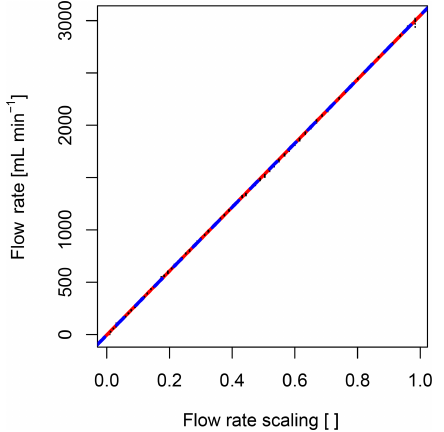
Figure 8. Linearity of two digital mass flow controllers verified by a conventional thermal mass flow controller for a series of 100 con- stant flow rate levels in the range of 0 to 3000smlmin − 1 . The ther- mal mass flow controller reading is shown on the y axis versus the set point of the digital mass flow controllers on the x axis (black dots). The set point range on the x axis from 0 to 1.0 is linearly re- lated to a flow rate range of 0 to 3000smlmin − 1 . Observed linear- ity errors of the digital mass flow controllers shown here are below 0.3% of the reading. Linear model fit of the digital mass flow con- troller of the “updraft channel” of the TEA system (dashed red line), and of the “downdraft channel” (dashed blue line), respectively.